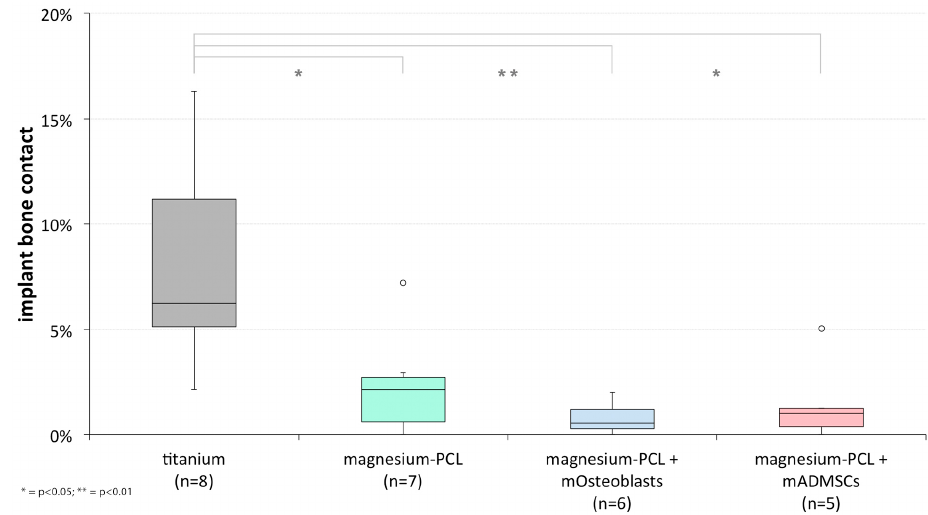
Figure 16. Implant bone contact (%) of uncoated titanium implants, non-previtalised Mg-PCL implants and Mg-PCL implants previtalised with either mOsteoblasts or mADMSCs (* = p < 0.05; ** = p < 0.01; whiskers = minimal and maximal values; horizontal line = median; circles = outliers).